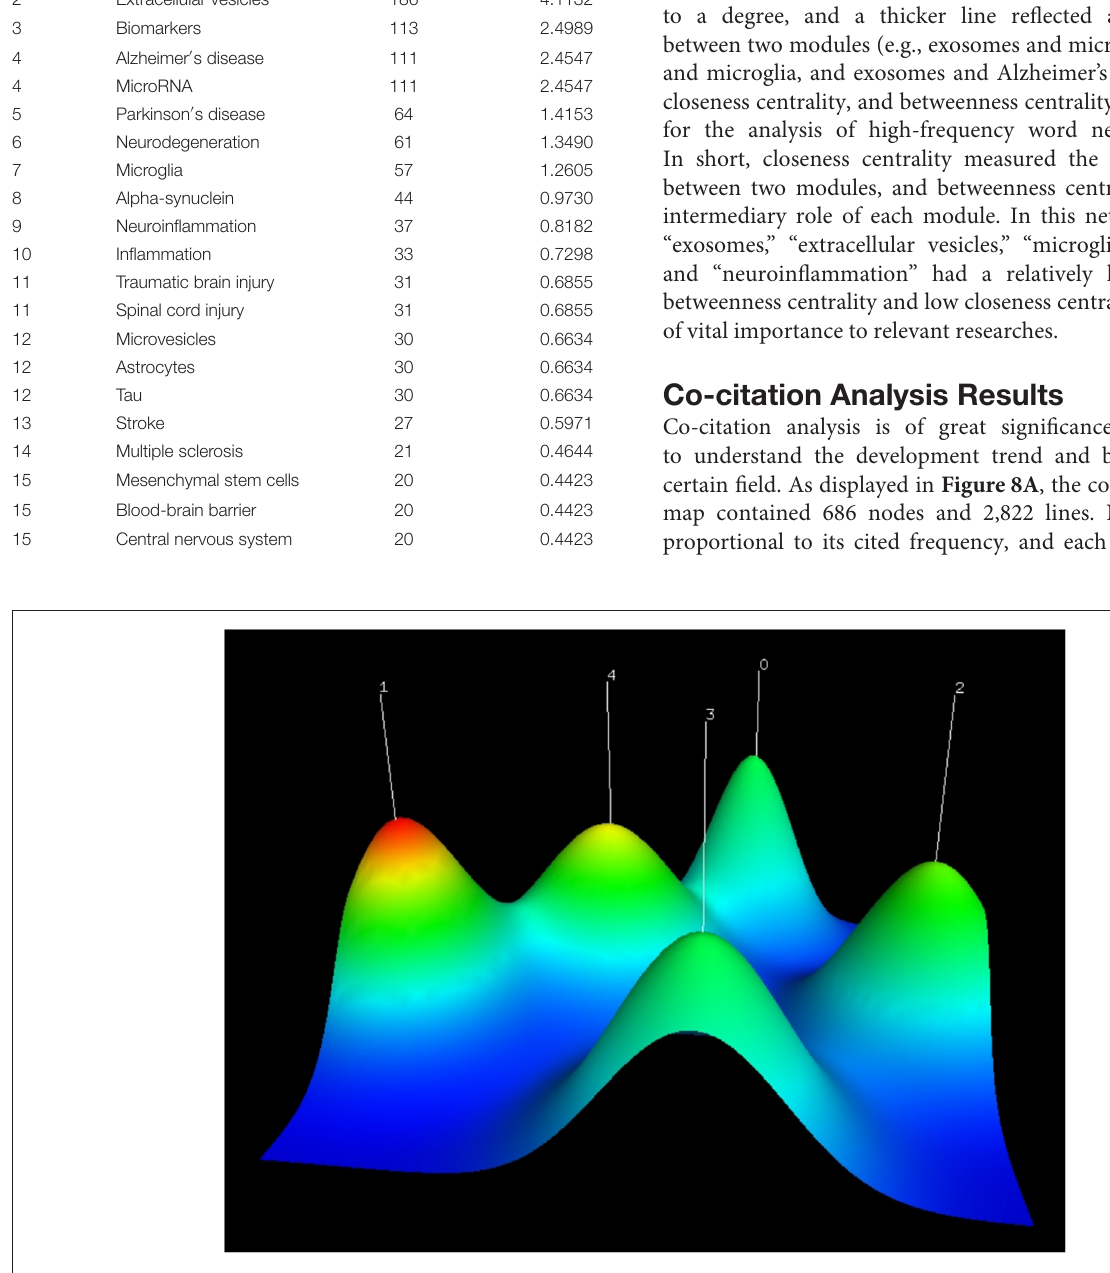
Frontiers in Neurology |